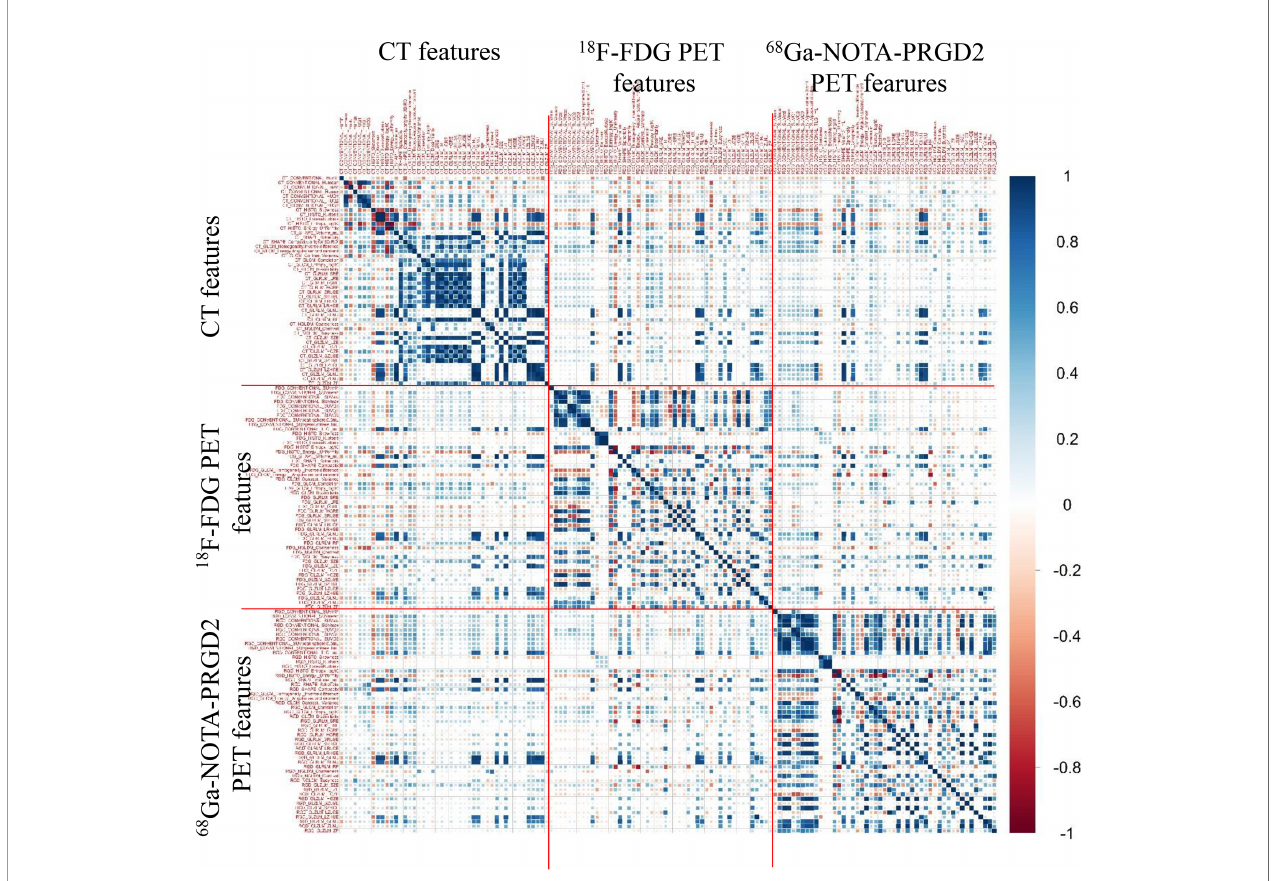
FIGURE 3 | Image feature correlation coef fi cient map of CT, 18 F-FDG PET and 68 Ga-NOTA-PRGD2